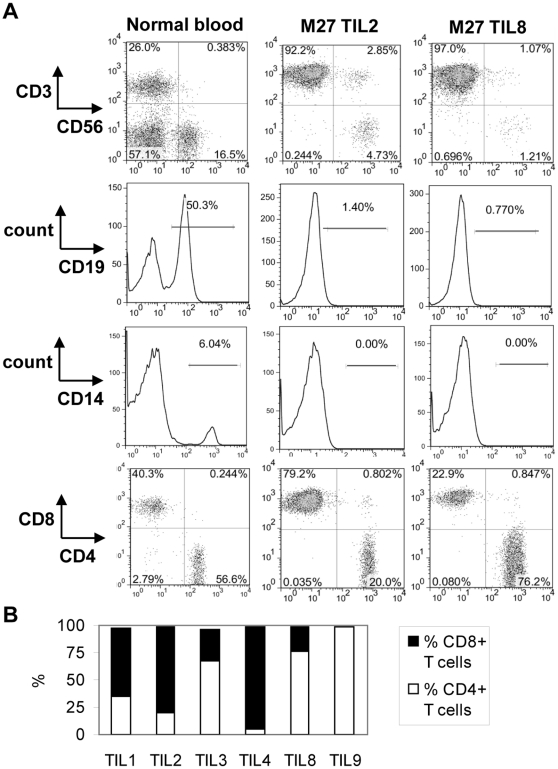
Flow cytometric analysis of TILs.(A) Profiles of representative TIL cultures (specimen M27, TIL cultures 2 and 8) stained for CD3, CD56, CD19, CD14, CD4 and CD8 are shown. Profiles from peripheral blood cells (PBCs) from a healthy donor are shown for comparison (“normal blood”). PBC profiles are gated on either lymphocytes (CD56xCD3, CD19, CD4xCD8) or total PBCs (CD14). TIL profiles are gated on live TILs based on forward scatter and side scatter for all plots. All CD4xCD8 profiles are also gated on CD3+ cells. (B) The proportion of CD4+ and CD8+ T cells (gated on CD3+ cells) are shown for all six independent TIL cultures derived from tissue specimen M27.